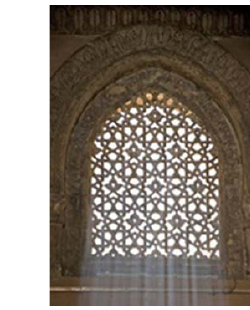
Figure 8-3 Madrasa umm al-sultan sha'ban. Figure 8-4 Madrasa umm al-sultan sha'ban Figure 8-5 Ibn tulun mosque